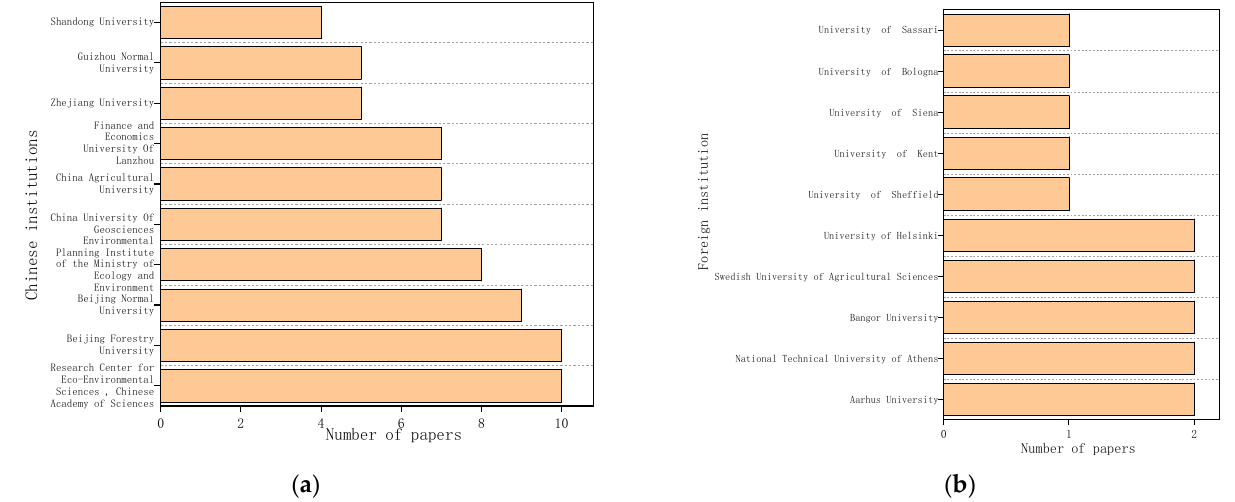
Figure 5. ( a ) Ranking of Chinese institutions in terms of the number of articles published; ( b ) ranking of foreign institutions in terms of the number of articles issued.